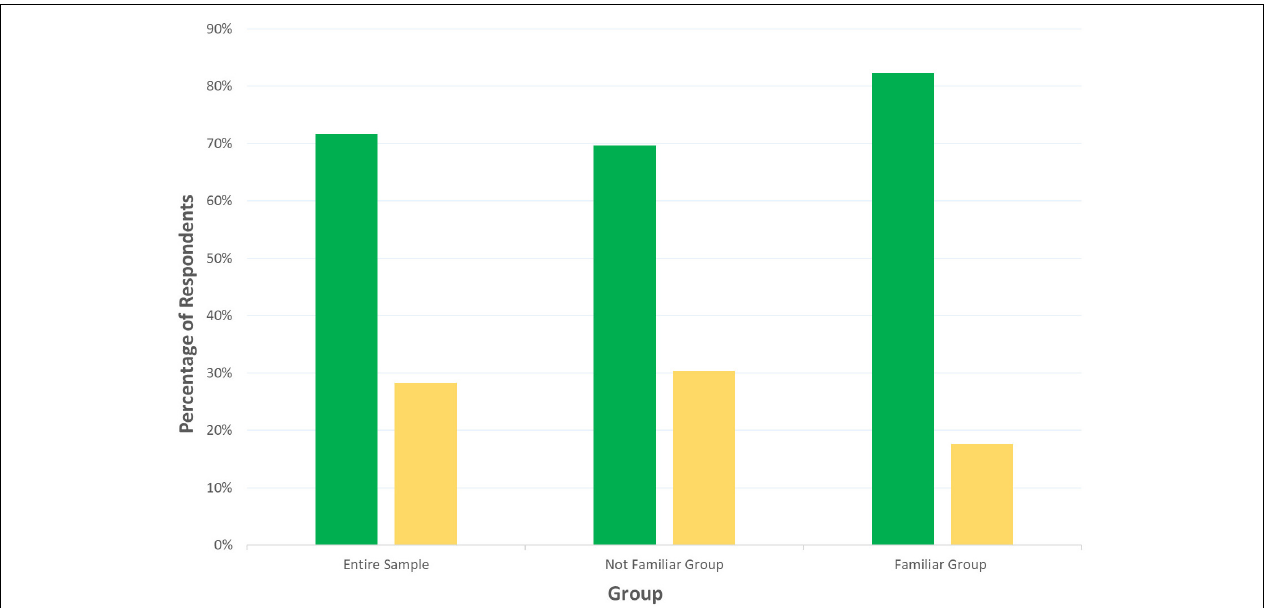
FIGURE 7 | Percentage of Mechanistic (green bars) and Mentalistic (yellow bars) respondents for the entire sample ( N = 106) on the left, the Not Familiar group ( N = 89), and the Familiar group ( N = 17) on the